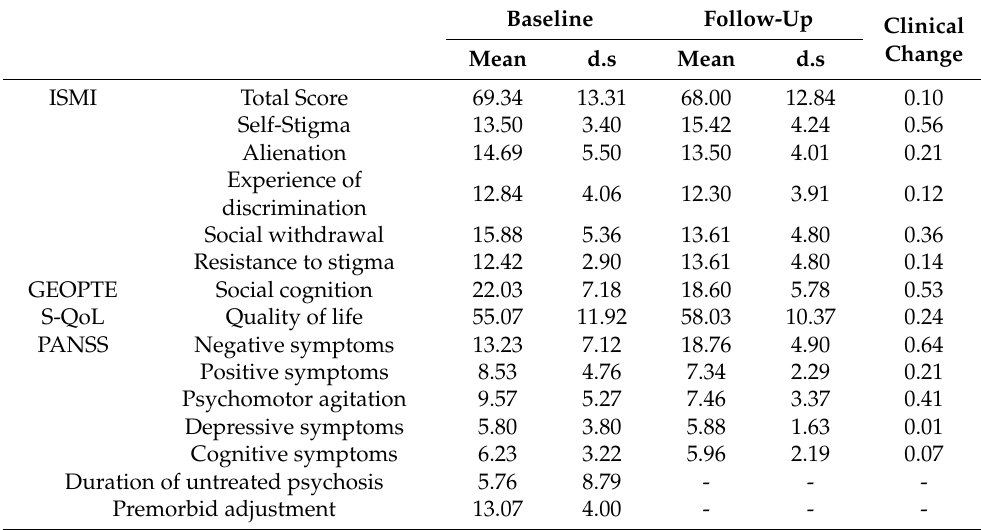
Table 2. Longitudinal comparison of indices between baseline and